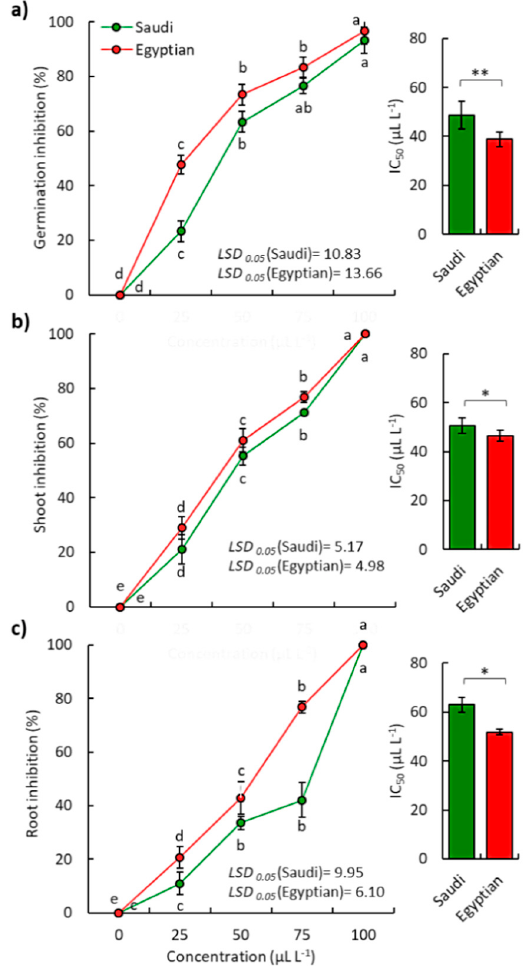
Figure 4. Phytotoxic effect of the EOs extracted from the aerial parts of both Saudi and Egyptian ecotypes of P. undulata on the ( a ) germination of seeds, ( b ) shoot growth, and ( c ) root growth of the weed Dactyloctenium aegyptium . Different letters on each line mean significant differences (one-way randomized blocks ANOVA). Data are mean value ( n = 3 ) and the bars represent the standard error. * p < 0.05, ** p < 0.01.